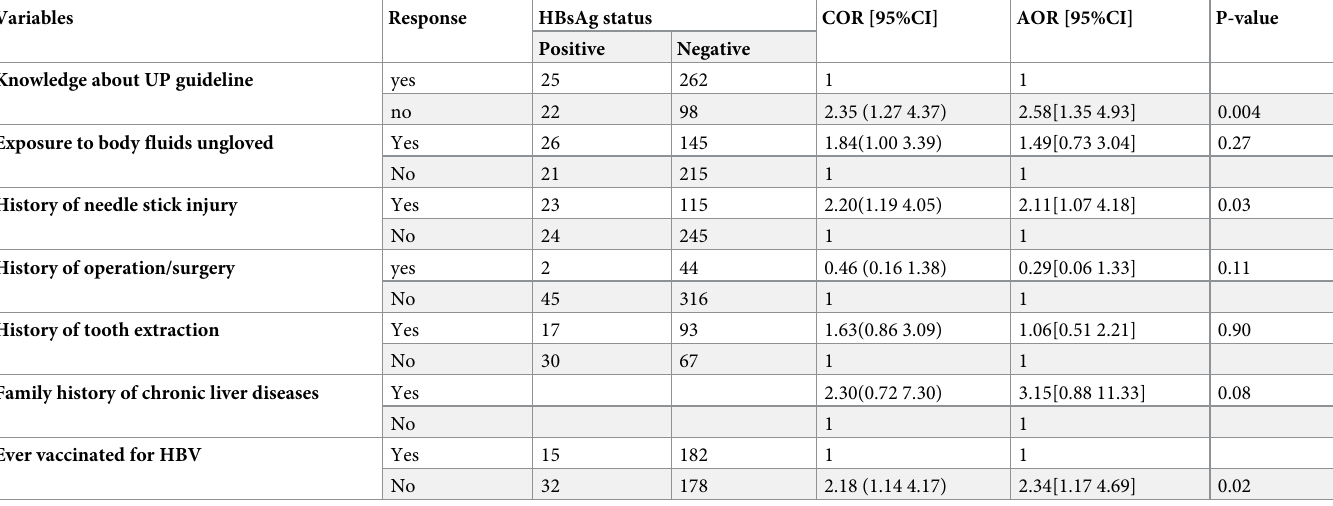
Table 2. Factors associated with HBsAg positive status among medical students at public health facilities in eastern Ethiopia, 2018 (n = 407).